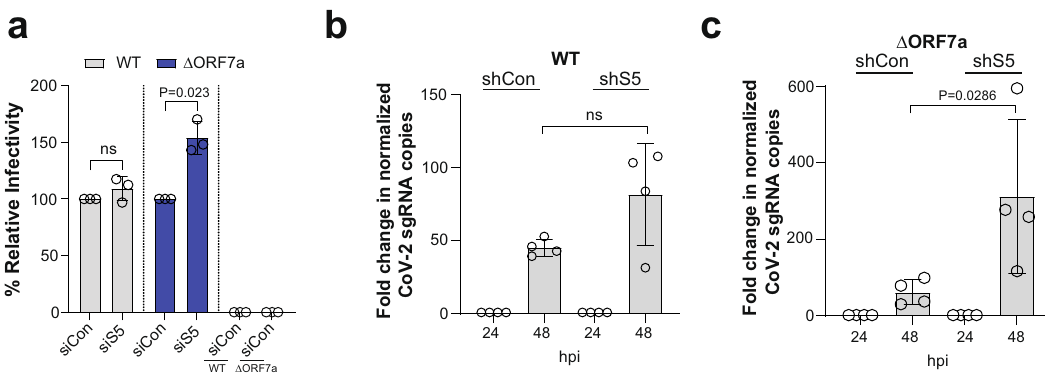
Fig. 6 ORF7a counteracts endogenous SERINC5. a Endogenous SERINC5 reduces SARS-CoV-2 entry in the absence of Orf7a. Calu-3 and M. dunni cells were infected with SARS-CoV-2 WT or Δ ORF7a virus produced in Calu-3 cells treated with siSERINC5 or siControl. SARS-CoV-2 Spike RNA copy numbers were determined by RT-qPCR at 6 hpi and percentage (%) relative infectivity was determined by setting the infectivity of virus from siControl treated cells to 100%. Results are presented as mean ± SD from n = 3 independent experiments. One-sample t-test (two-tailed) was performed. Endogenous SERINC5 reduces SARS-CoV-2 replication in the absence of ORF7a. Calu-3 cells stably expressing shSERINC5 or shControl were infected with either b SARS-CoV-2 WT or c Δ ORF7a virus. Cells were harvested at 24 and 48 hpi, SARS-CoV-2 Spike RNA copy numbers were determined by RT-qPCR and normalized to GAPDH. Graphs show fold change of normalized SARS-CoV-2 Spike RNA levels relative to 24 hpi conditions. Results are presented as mean ± SD from n = 4 independent experiments. Mann Whitney test (two-tailed) was performed. (hour post infection, hpi; negative control siRNA, siCon; SERINC5 siRNA, siS5; negative Control shRNA, shCon; SERINC5 shRNA, shS5; si, Mus dunni cells, M. dunni cells; not signi fi cant,